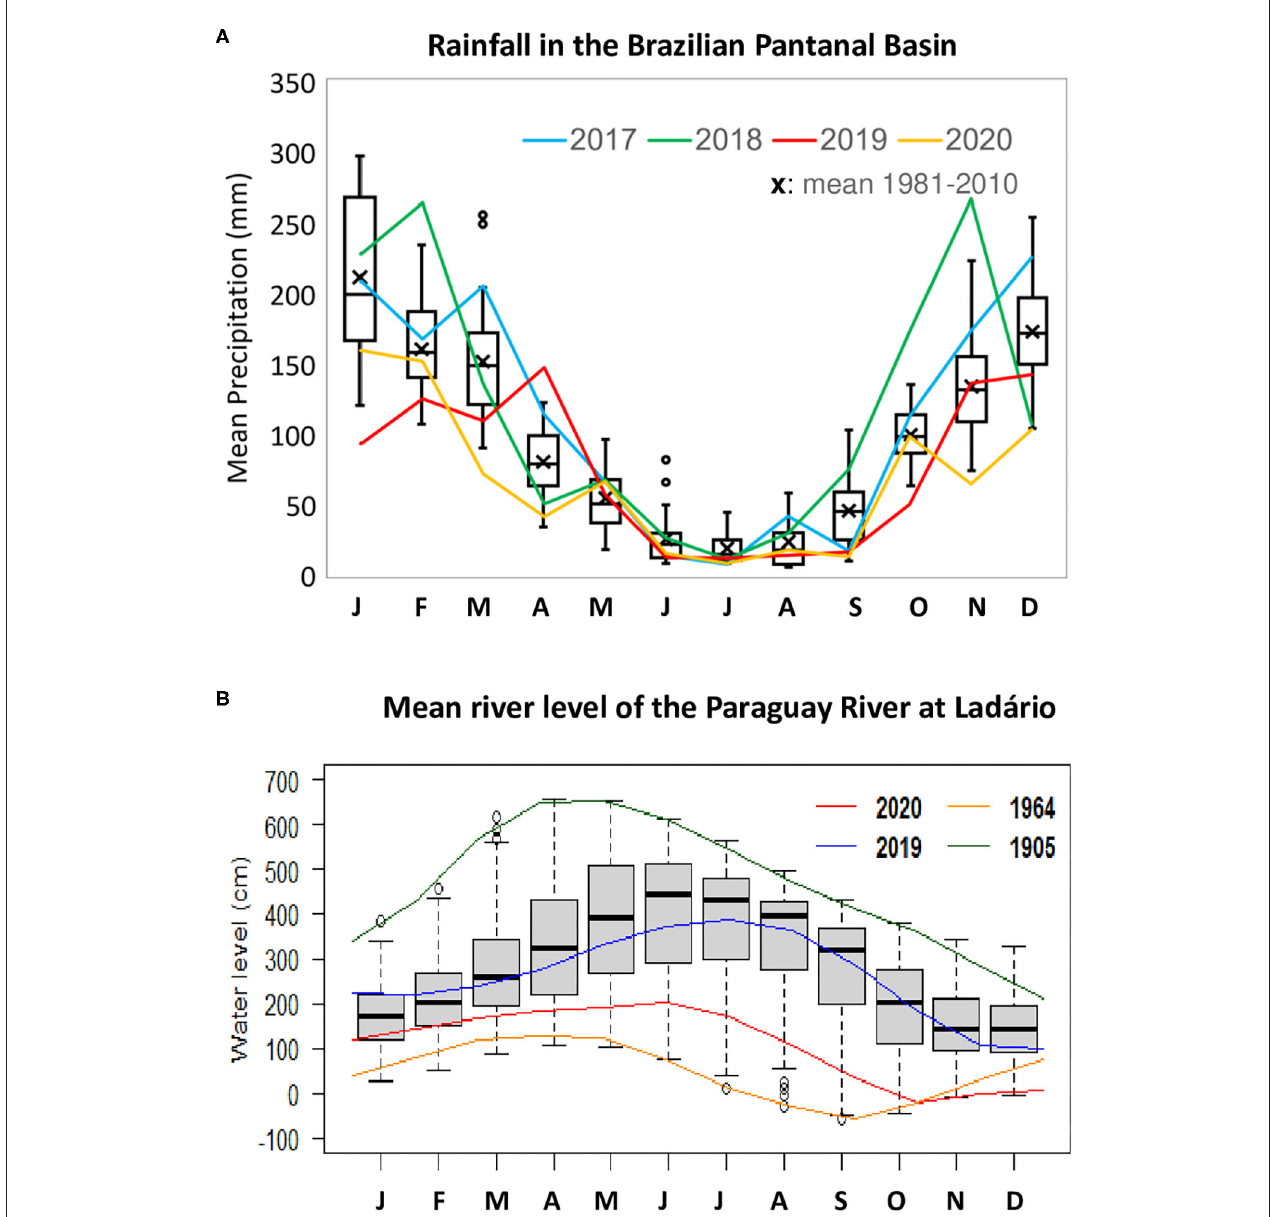
FIGURE 2 | (A) Annual variation of rainfall in the Brazilian Pantanal. Mean is indicated by “x” with the whiskers showing the standard deviation. Long-term mean is from 1981 to 210. The figure also shows rainfall for 2017, 2018, 2019, and 2020. Data is from CHIRPS. (B) Annual variation of levels of the Paraguay River at the Ladário gauge station. The figure also shows river levels for 1905, 1964, 2019, and 2020. Source of data: Brazilian